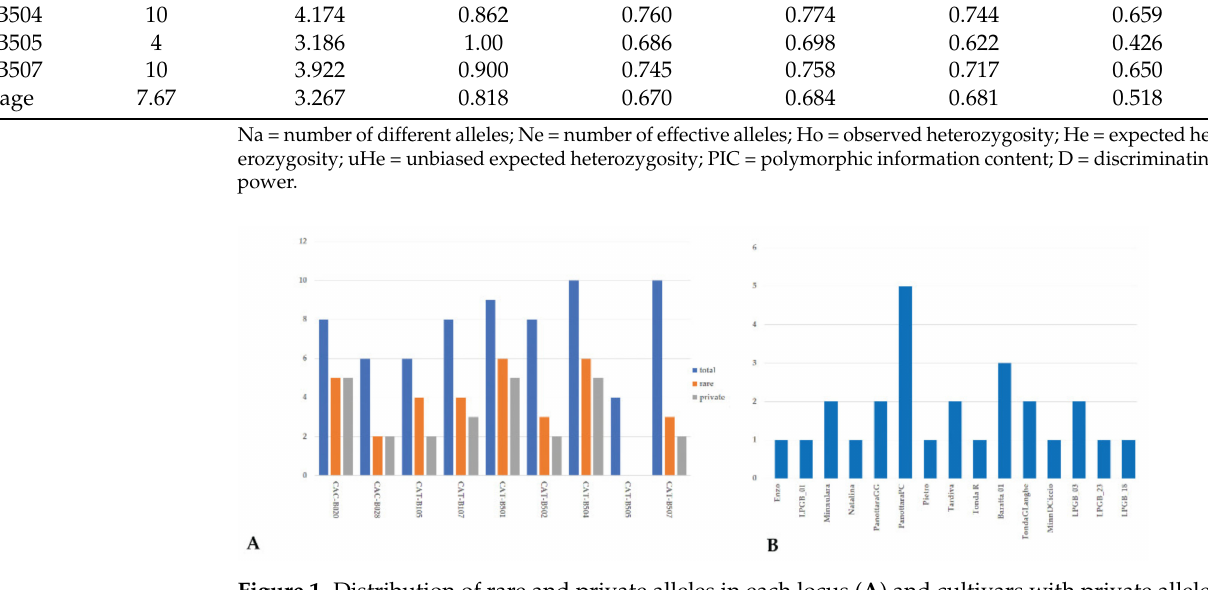
Table 2). Average distances (expected heterozygosity) between genotypes in the same cluster were 0.8247 for Cluster I and 0.5166 for Cluster II (Table